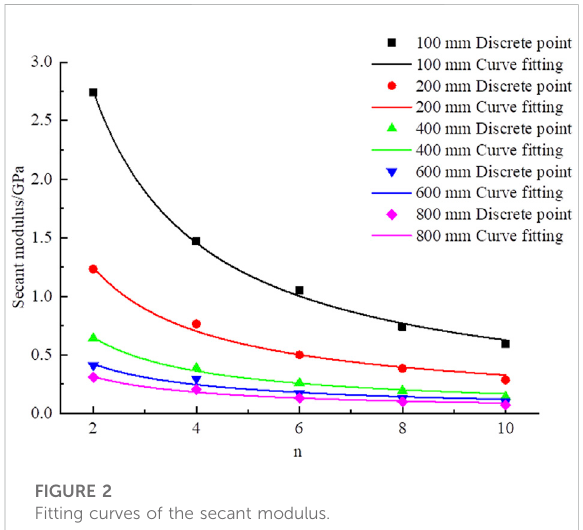
FIGURE 2 Fitting curves of the secant modulus.